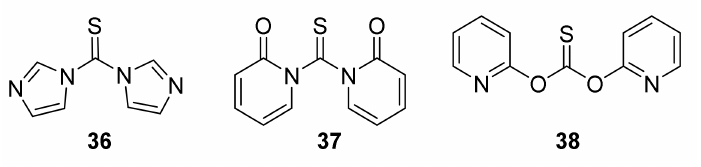
Figure 10. Thiophosgene surrogates.